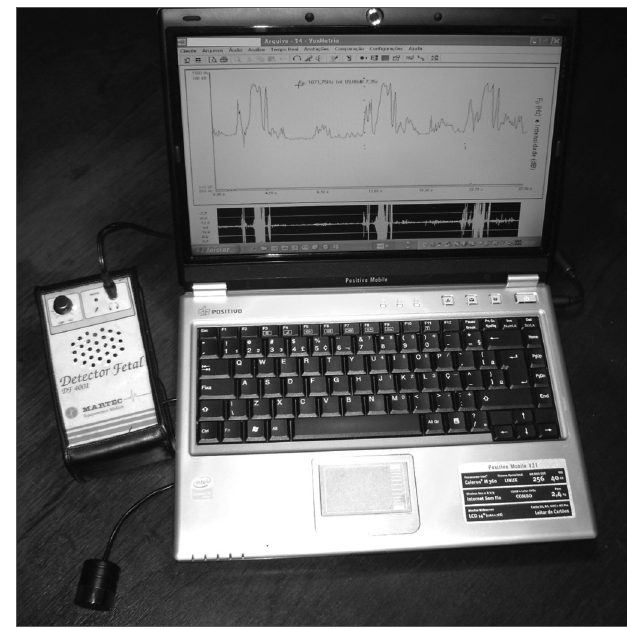
Figure 2. Doppler sonar coupled to a notebook